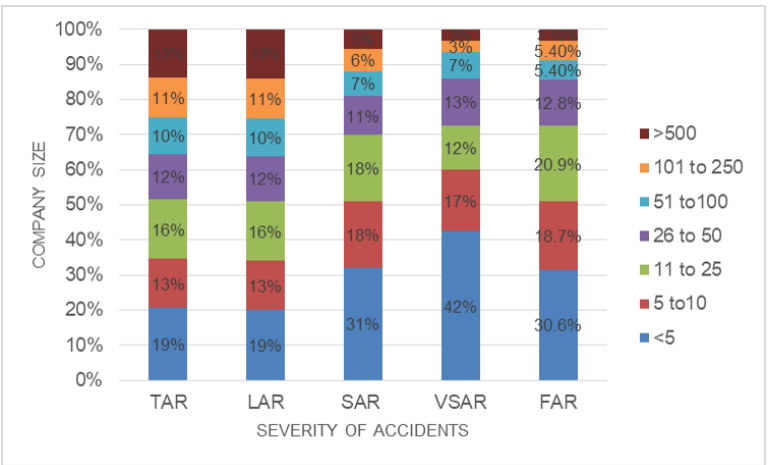
Figure 3. Distribution of severity rates versus company